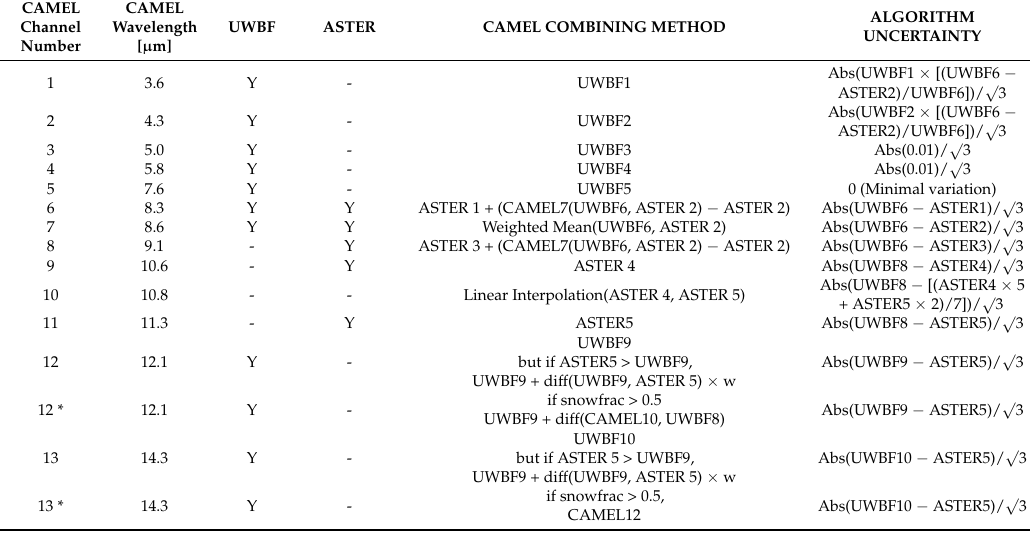
Table 1. Bands, inputs, and methodology for generating the CAMEL (Combined ASTER and MODIS Emissivity over Land, combining the Moderate Resolution Imaging Spectroradiometer (MODIS) and the Advanced Spaceborne Thermal Emission and Reflection Radiometer (ASTER)) product and algorithm uncertainty estimates *. Note University of Wisconsin Baseline-Fit (UW BF) is based on the MODIS emissivity product.